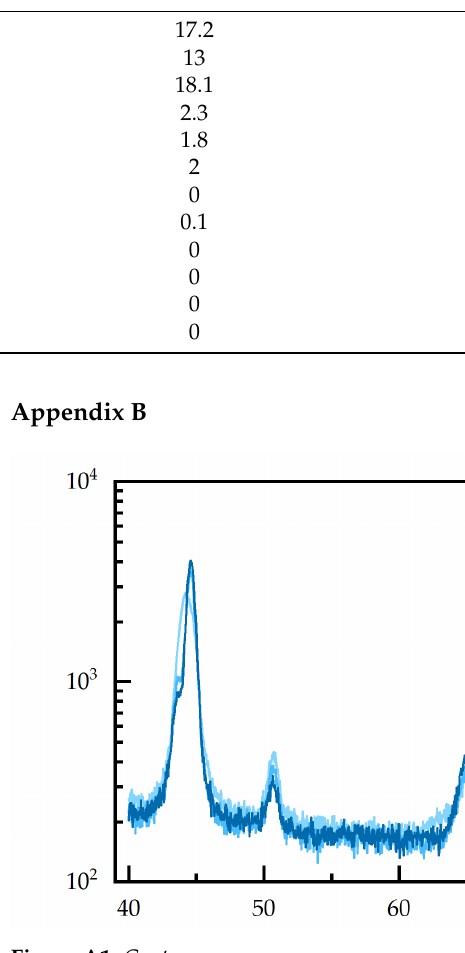
Figure A1. XRD diffractograms of the subjected specimens in their respective groups for better comparability. References